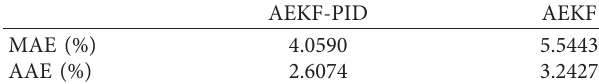
Table 3: SOC estimation with non-Gaussian